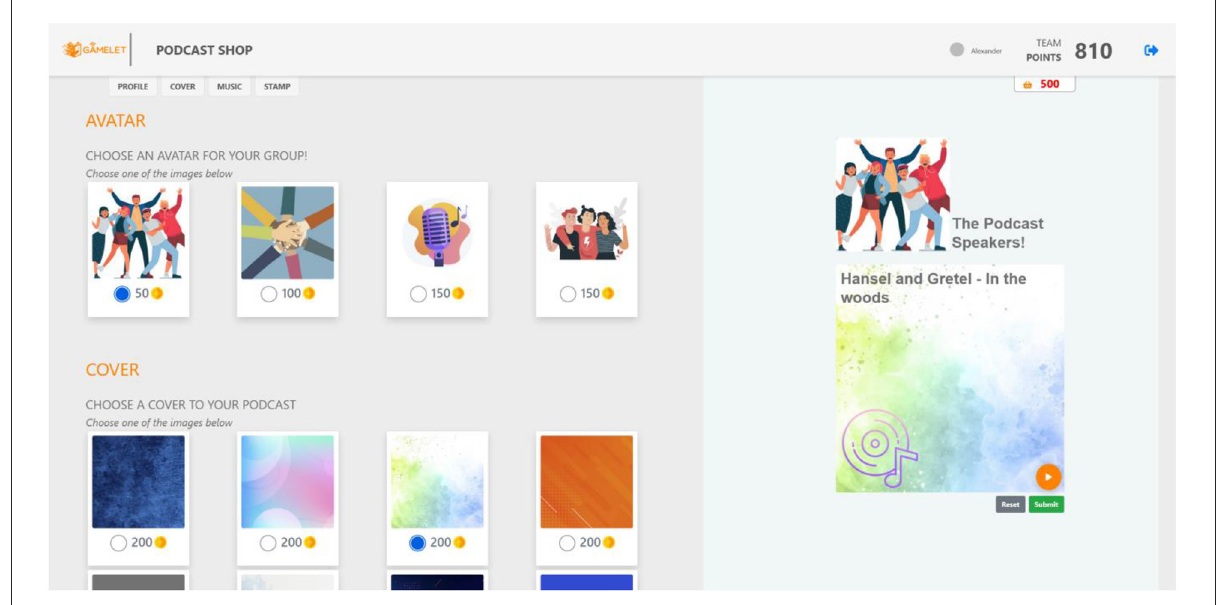
FIGURE12 Shopping area that allows students to personalise the presentation of their podcast and actors.